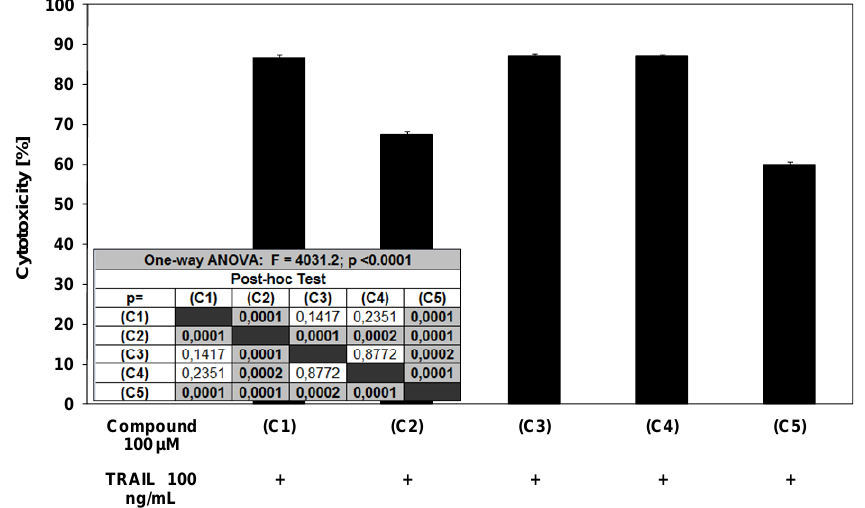
Figure 5. Statistical analysis of cytotoxic activity of TRAIL in combination with chalcones and dihydrochalcones in LNCaP prostate cancer cells. The data are expressed as mean ±SD (n = 12) (p <